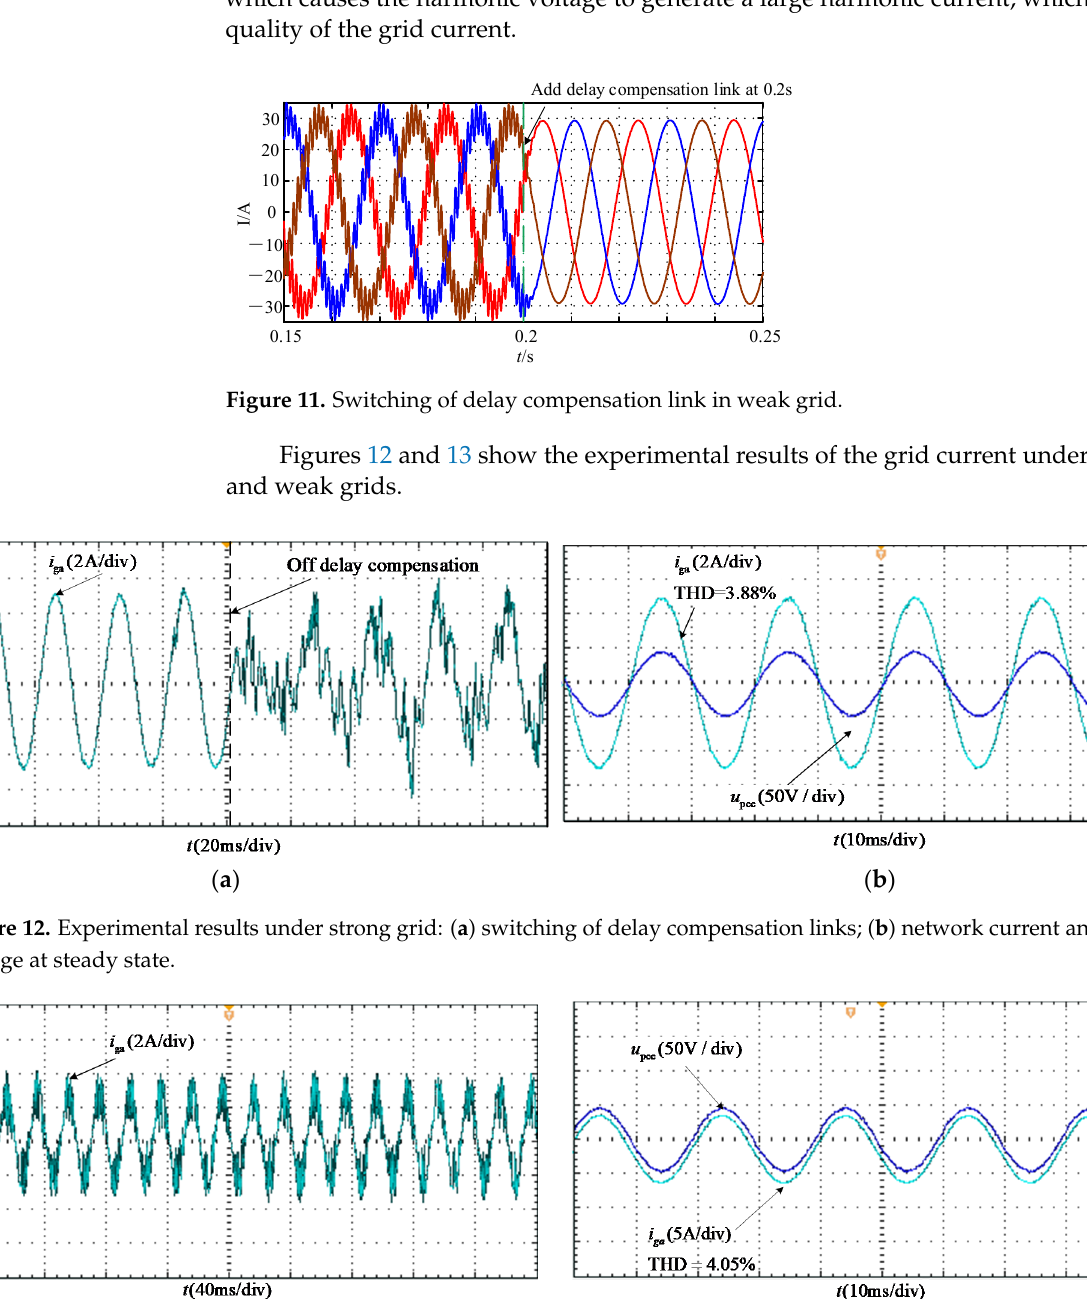
Figure 10. Switching of delay compensation link in strong grid.